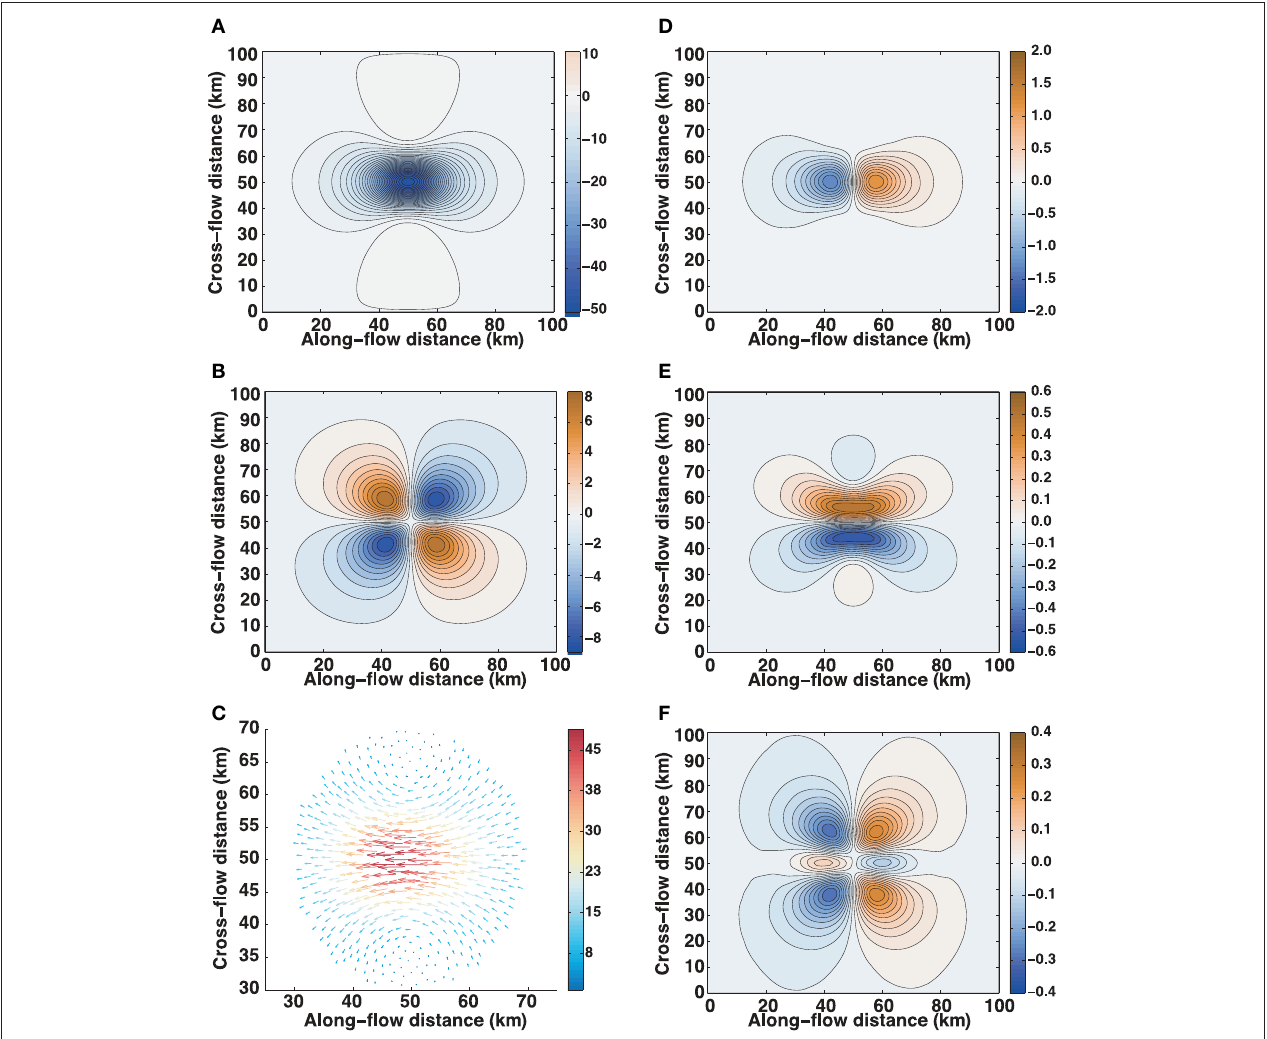
FIGURE 1 | Perturbation at t = 5 s: (A) along-flow velocity; (B) cross-flow velocity; (C) vector velocity (colored by magnitude) within 20km of sticky-spot center; (D) along-flow stress; (E) shear stress; (F) cross-flow stress. Velocities in m a − 1 , stresses in Pa. Mean velocity is from left to right in the positive along-flow